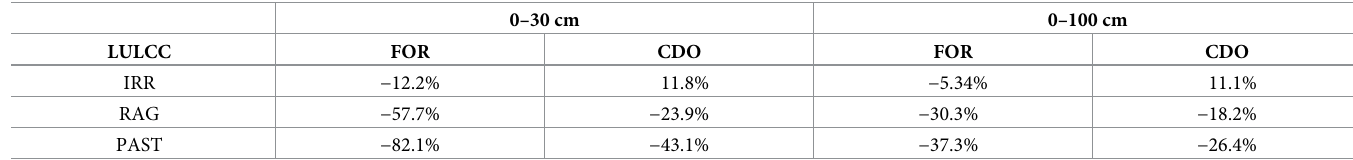
Table 4. Percentage differences in soil carbon stocks between agricultural LUs and native vegetation LCs in Western Bahia for 0–30 cm and 0–100 cm depths.